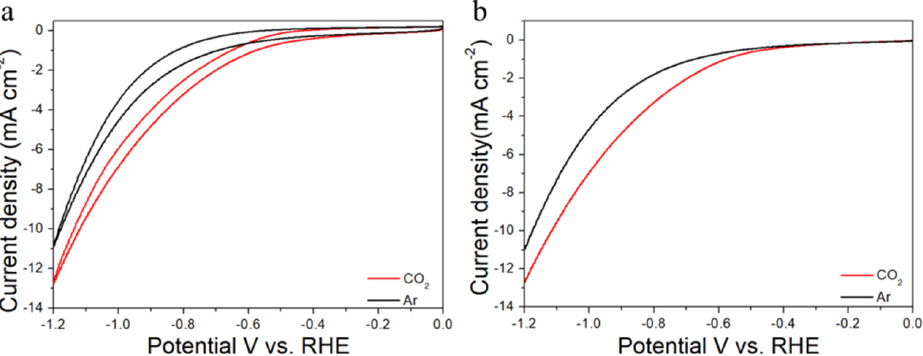
Figure 5. Cyclic voltammograms ( a ) and linear scan voltammograms ( b ) of Au 75 Cu 25 /C in Ar saturated and CO 2 -satruated 0.1 M KHCO 3 solutions collected at a scan rate of 20 mV s − 1 .